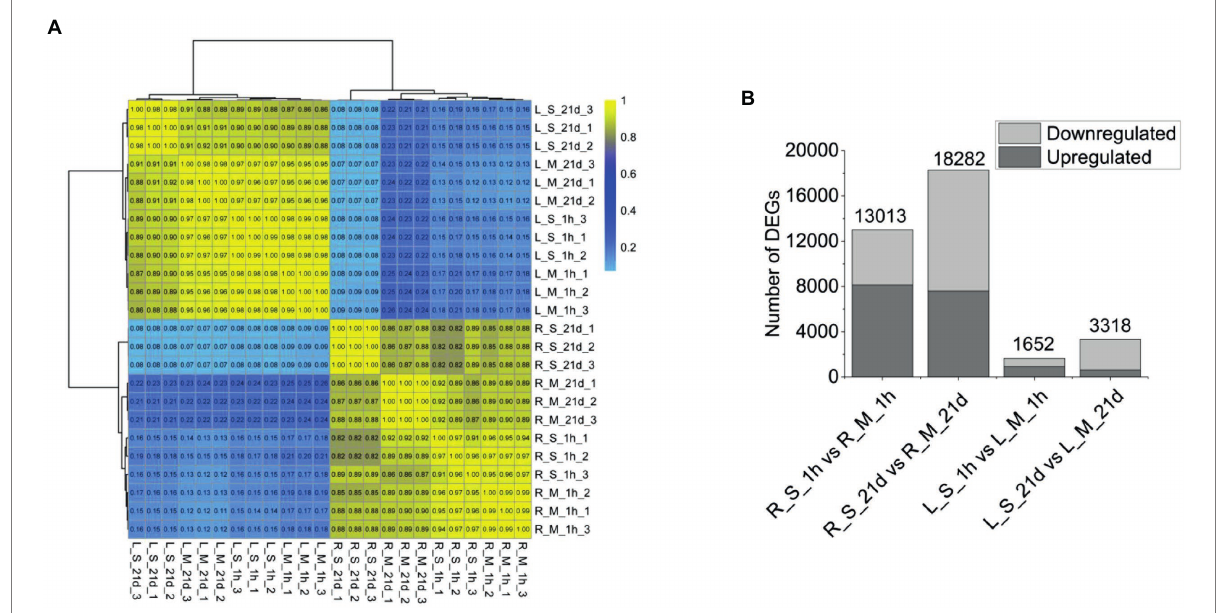
FIGURE 2 RNA-Seq data and DEGs resulted from S. portulacastrum plants treated and untreated with 400 mM NaCl. (A) Hierarchical clustering of 24 samples based on the correlation coefficient ( r 2 ), where R_M_1h and R_M_21d were samples of roots (1 h and 21 days) without NaCl treatment; L_M_1h and L_M_21d were samples of leaves (1 h and 21 days) without NaCl treatment; R_S_1h and R_S_21d were samples of roots (1 h and 21 days) with NaCl treatment; and L_S_1h and L_S_21d were samples of leaves (1 h and 21 days) with NaCl treatment. (B) Statistics of DEGs numbers in roots and